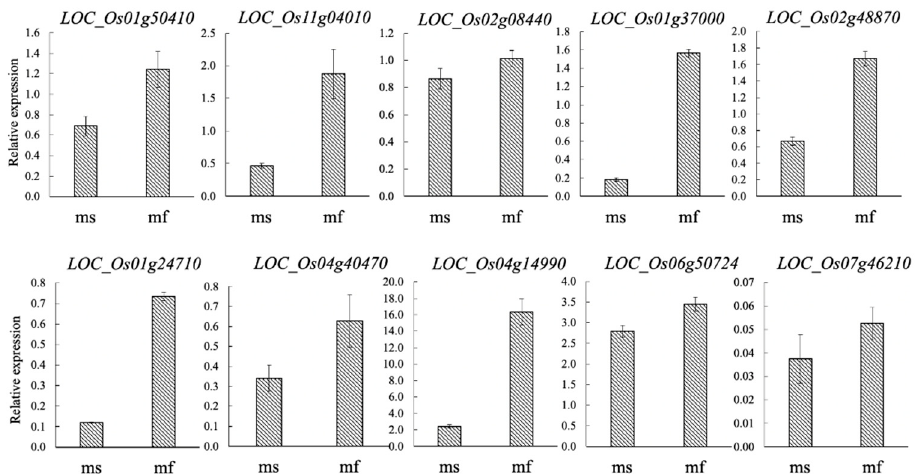
Figure 4. Validation of expression profiles of 10 DEGs by qRT - PCR . MS, sterile temperature; MF, fertile temperature . The relative expression values were normalized to the rice actin gene . The results were obtained from three technical replicates . Error bars indicate standard deviation .